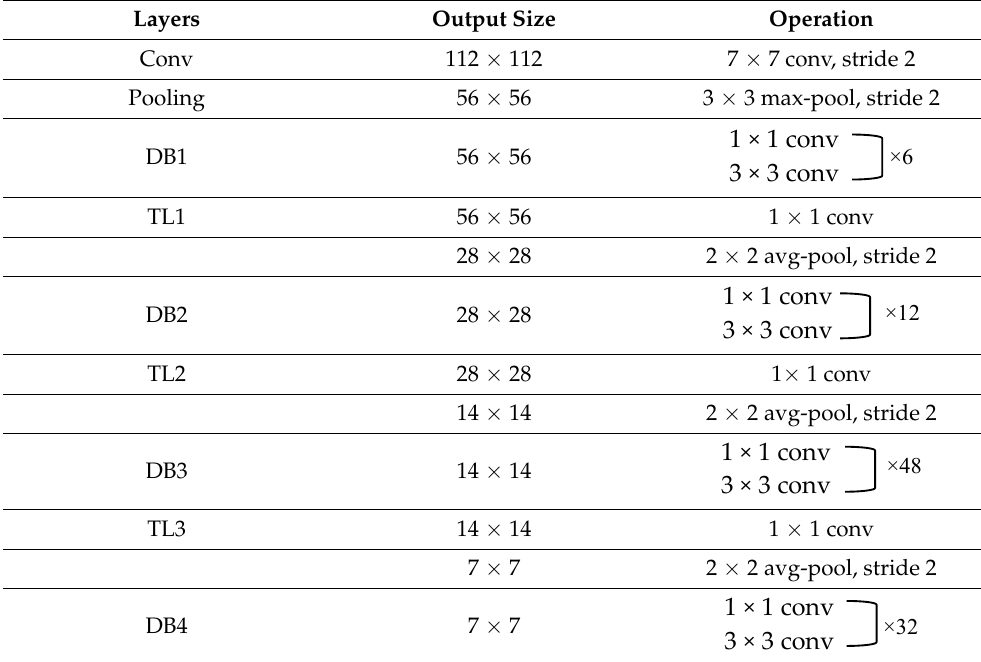
Table 3. The convolutional base of the DenseNet201 network.